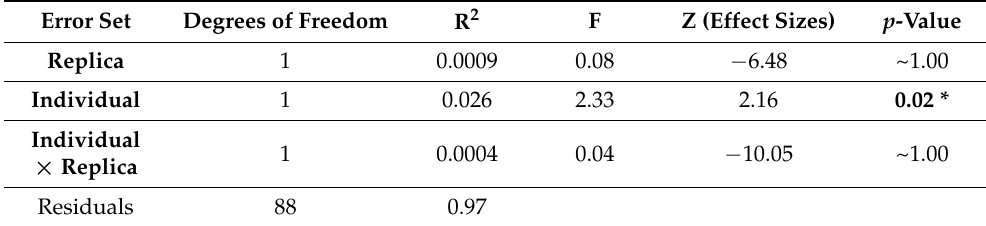
Table 1. Multivariate Procrustes ANOVA between the dependent variable of error set and the independent variables of individual, replica, and their interaction, to test for inter-observer error in landmarking the specimens. Asterisks indicate significance: * p -value ≤ 0.05; ** p -value ≤ 0.01; *** p -value ≤ 0.001.